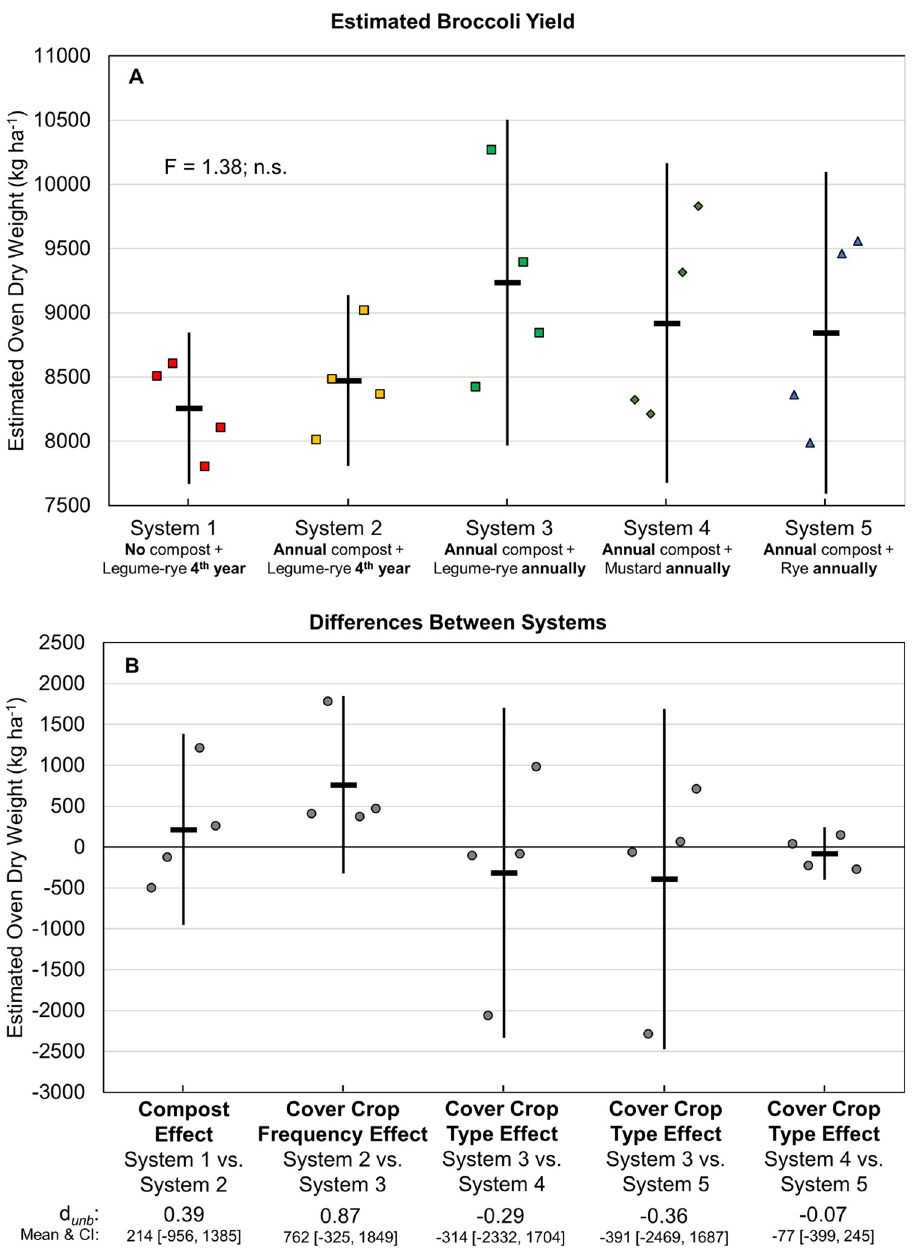
Fig 9. Cumulative, estimated, marketable broccoli yield over six years. Mean cumulative broccoli yield (A) and mean paired differences between systems (B) in 5 organic vegetable systems. Yields are oven-dry biomass. Systems differed by annual compost additions, cover crop type and cover cropping frequency. Error bars are 95% confidence intervals (CI) around the mean (horizontal line). Data points are replicates 1 through 4 averaged across years and are clustered around the mean left to right so as not to obscure the mean and CI. The standardized effect size (Cohen’s unbiased d , d ) is shown below the x-axis in plot B. Broccoli was only grown during 6 of the first 8 years of the unb